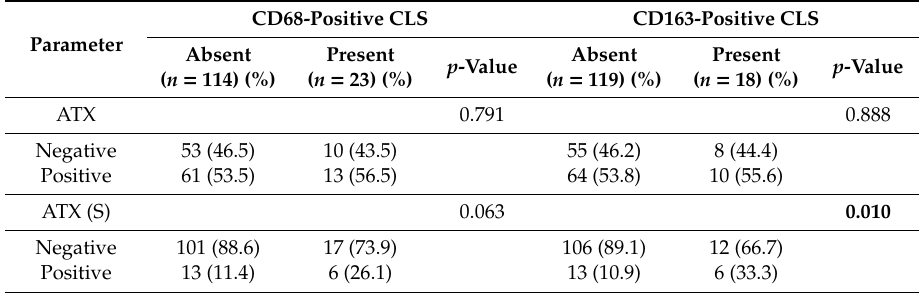
Table 5. Expression of ATX-LPA signaling-related proteins according to CD68- and CD163-positive crown-like structure (CLS) status in adipose